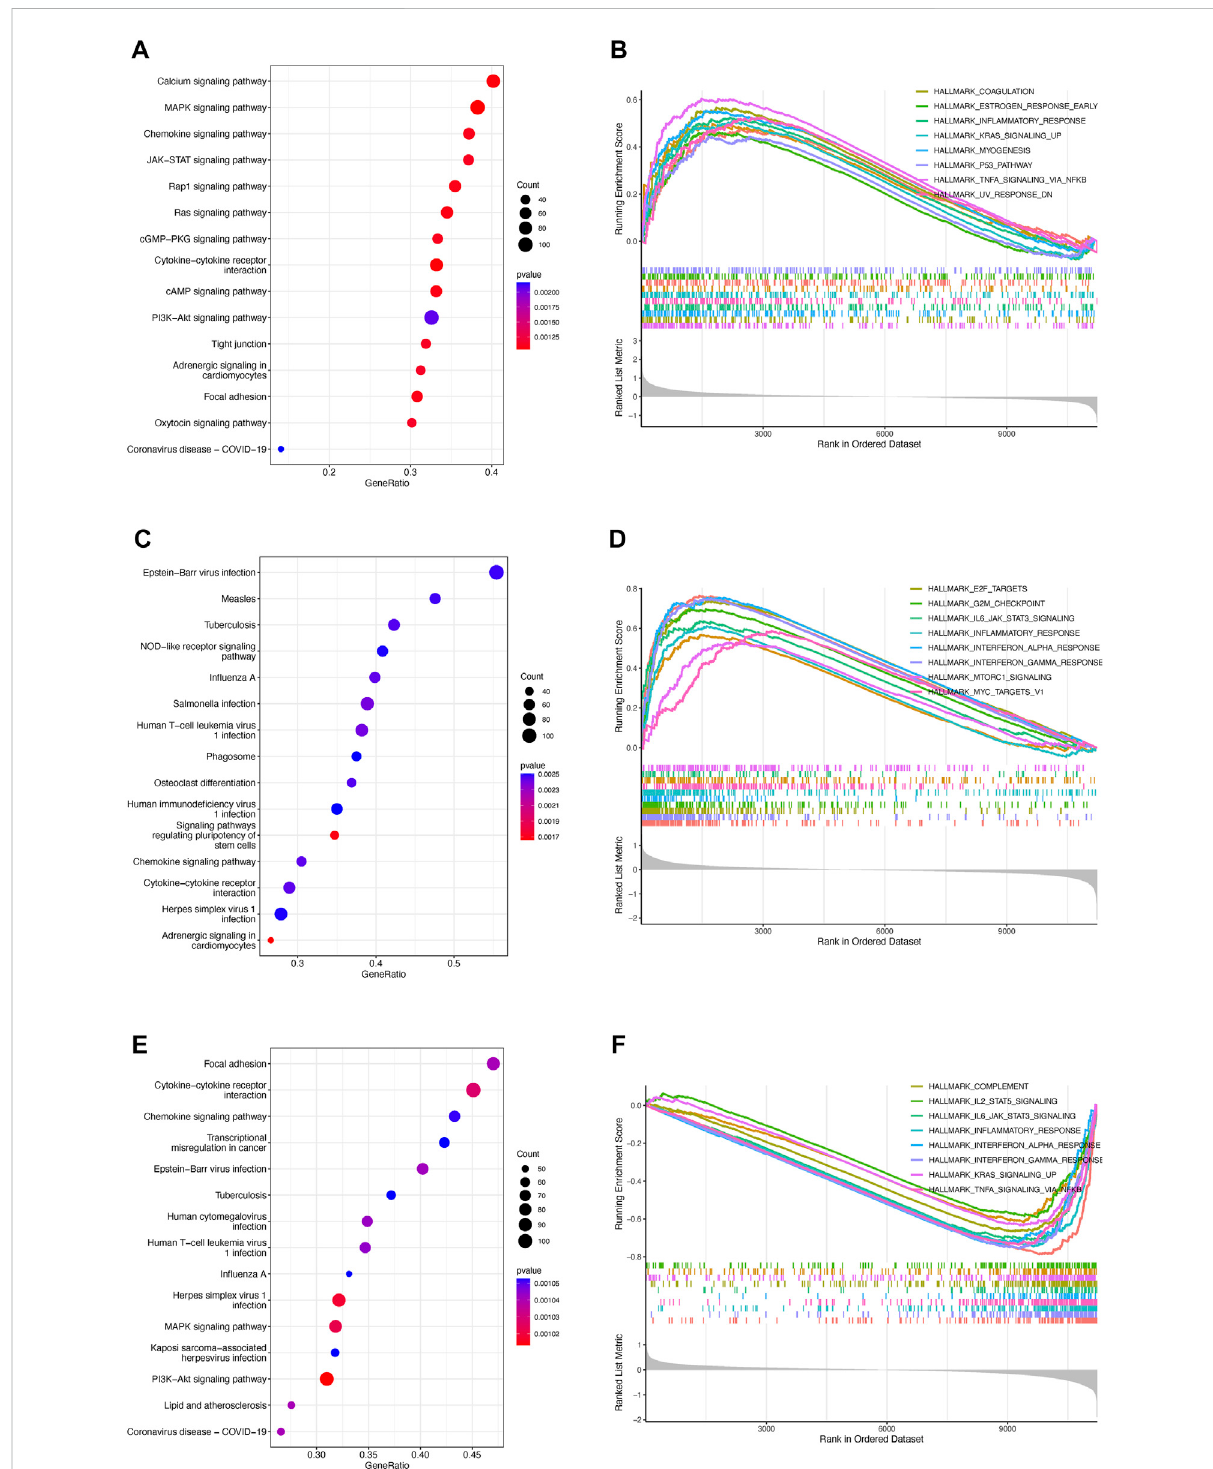
FIGURE 3 Enrichment analysis of TPRs (A – F) . Top 5KEGG enriched gene pathway-related catalogsand top 10 GSEA of tumor-associated items incluster 1 (A,B) , cluster 2 (C,D) , and cluster 3 (E,F)